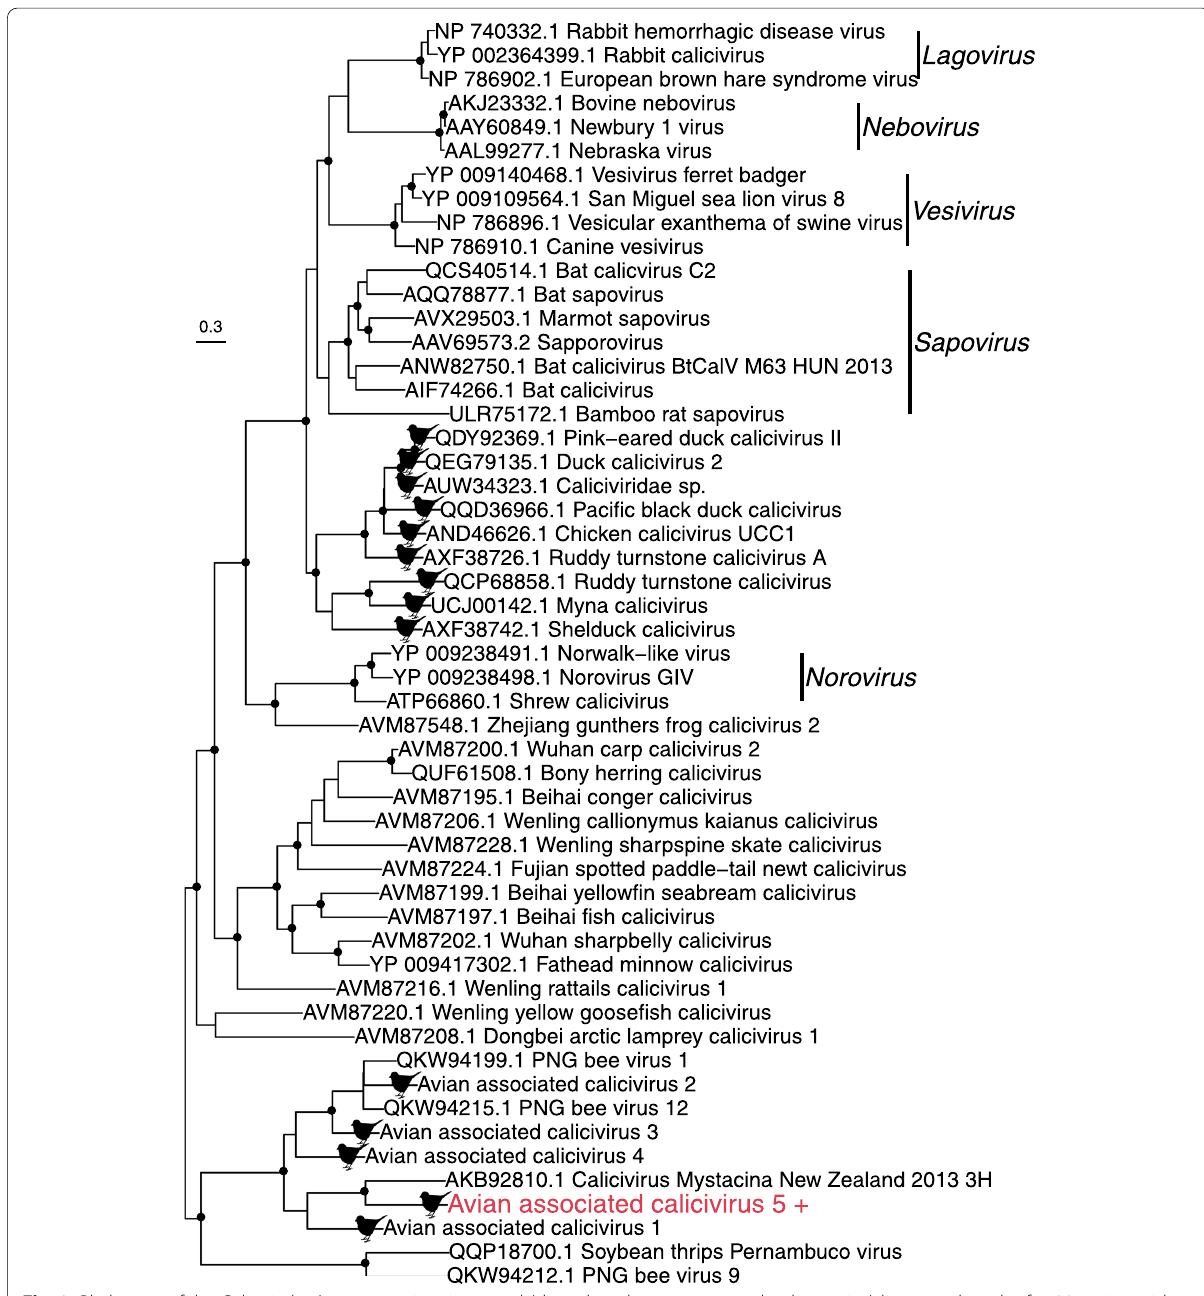
Fig. 2 Phylogeny of the Caliciviridae (representative viruses only) based on the non-structural polyprotein (alignment length of 1132 amino acids post trimming). The virus obtained this study is shown in red and has a ‘ ’ after the name. Viruses found in birds are marked with a bird silhouette. + Related viruses are shown in black. Black circles on nodes show bootstrap support values of more than 90%. Branches are scaled according to the number of amino acid substitutions per site, shown in the scale bar. The tree is midpoint rooted for purposes of clarity